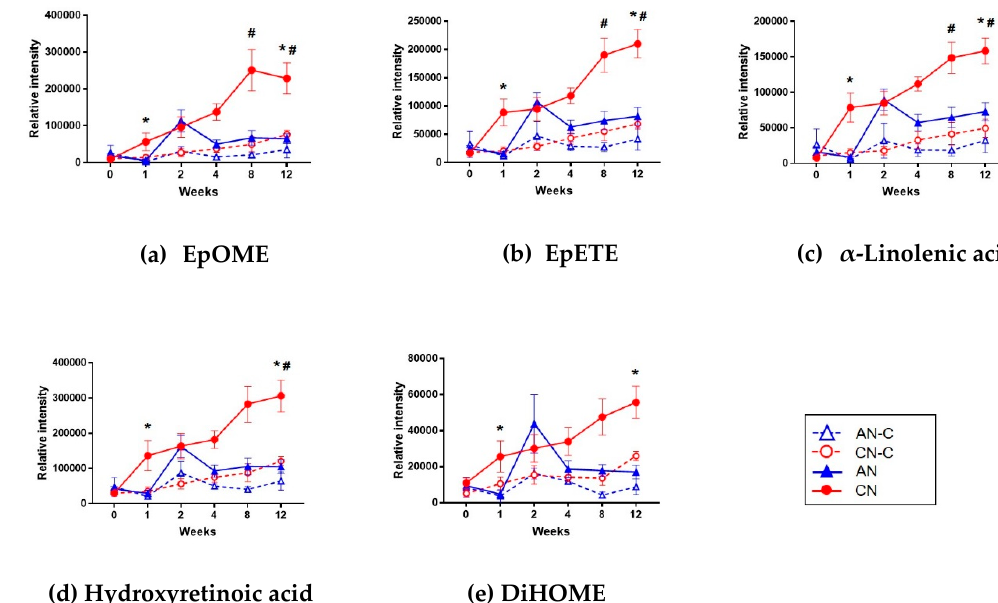
Figure 6. Relative intensity of the five identified urinary biomarkers predictive of the progression of nephritis. ( a ) EpOME, ( b ) EpETE, ( c ) α -linolenic acid, ( d ) hydroxyretinoic acid, and ( e ) DiHOME. Data are shown as mean values ± SEM. * q < 0.05 vs. AN; # q < 0.05 vs. CN-C. AN, acute nephritis; AN-C, control group for acute nephritis; CN, chronic nephritis; CN-C, control group for chronic nephritis; DiHOME, dihydroxyoctadecenoic acid; EpETE, epoxyeicosatetraenoic acid; EpOME, epoxyoctadecenoic acid.